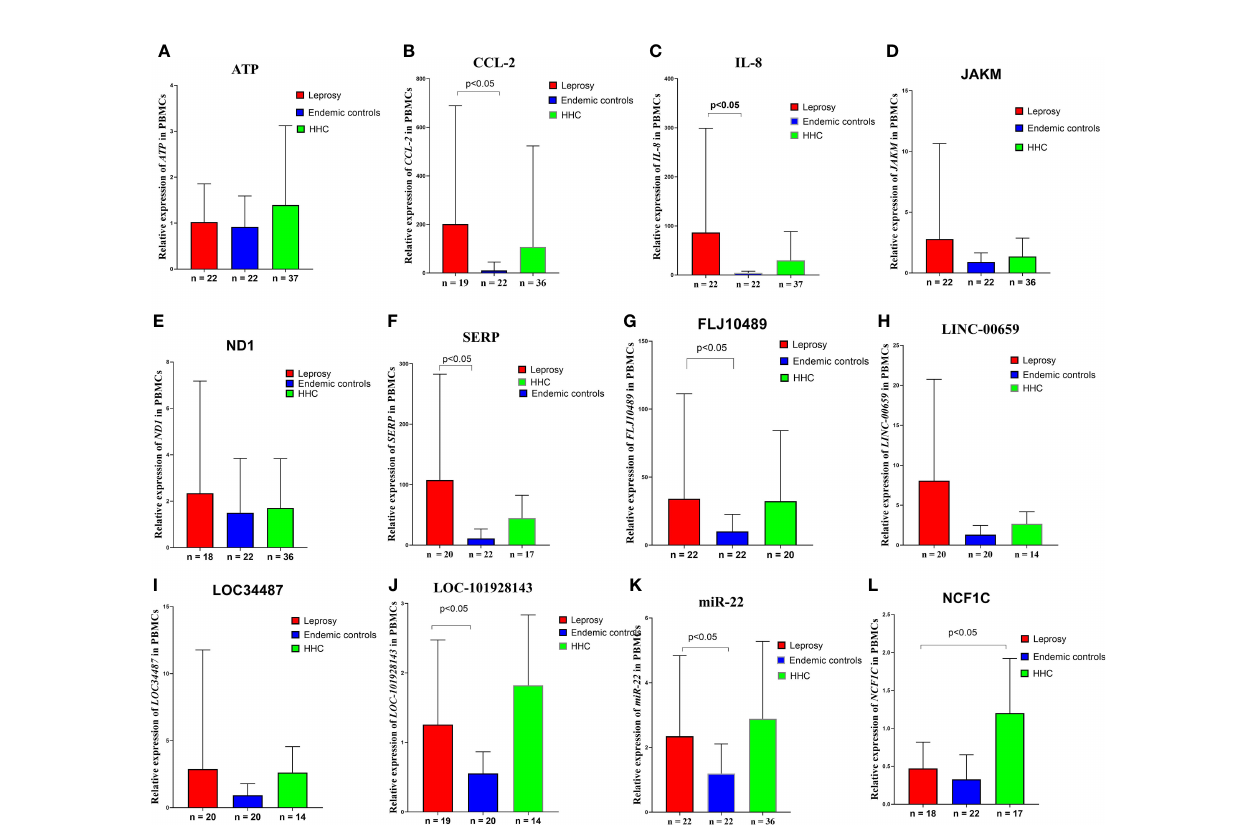
FIGURE 6 | Gene expression levels in the M. leprae -stimulated PBMCs in the validation cohort. Differences in ATP , CCL2/MCP-1 , IL-8 , JAKM , ND1 , SERP , FLJ10489 , LINC00659 , LOC34487 , LOC101928143 , MIR22 , and NCF1C expression levels in (A – L) M. leprae -stimulated PBMC of leprosy patients, HHCs, and ECs. The cycle threshold (Ct) values from real-time PCR were normalized to the internal reference gene ( GAPDH ). 2 - DD CT values are displayed. Kruskal – Wallis test and Mann – Whitney test for nonparametric data were used to evaluate statistical differences. MB, multibacillary; PB, paucibacillary; HHCs, healthy house contacts; ECs, endemic controls; DEG, differentially expressed gene; PBMC, peripheral blood mononuclear